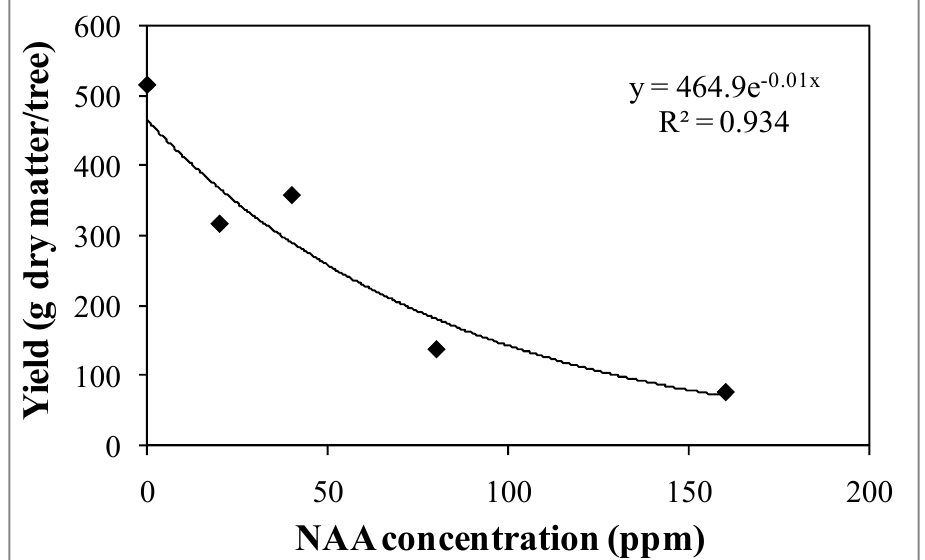
Figure 8. Relationship between NAA concentrations and the yield per tree at the end of the vegetative season (2019) in a young SHD olive orchard of the cultivar Sikitita. Values are means of 4 replicates per treatment.